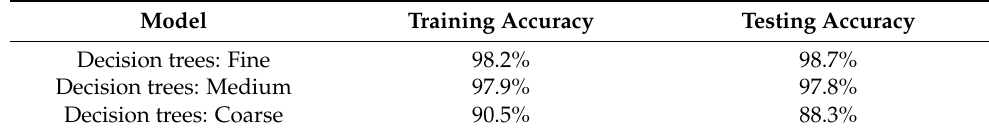
Table 4. Accuracy of tree classifiers.